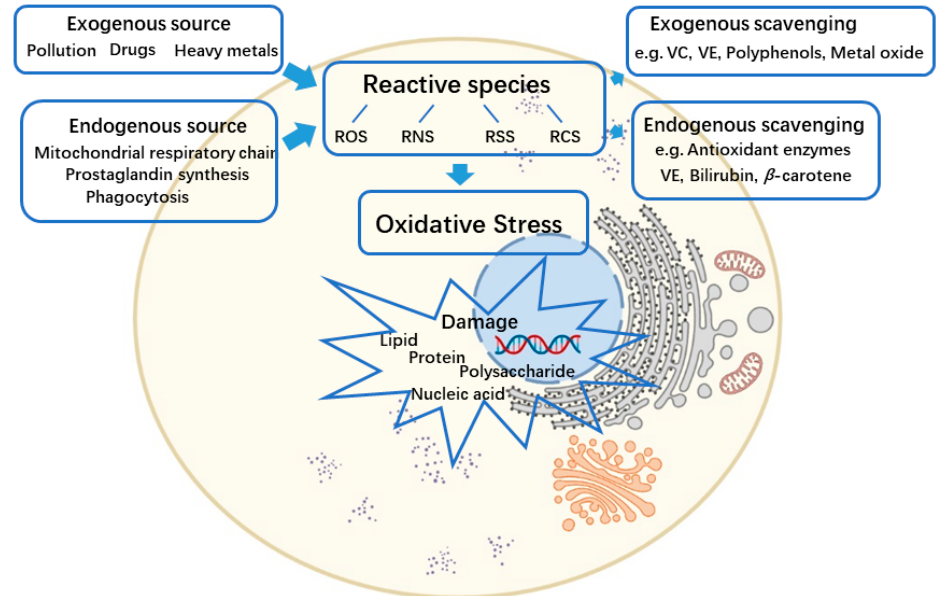
Figure 1. The imbalance between the generation of reactive species and the antioxidant defense system results in oxidative stress and further damage to cellular macromolecules. ROS—reactive oxygen species; RNS—reactive nitrogen species; RSS—reactive sulfur species; RCS—reactive carbonyl species; VC—ascorbic acid; VE—tocopherol. Created by BioRender.com.